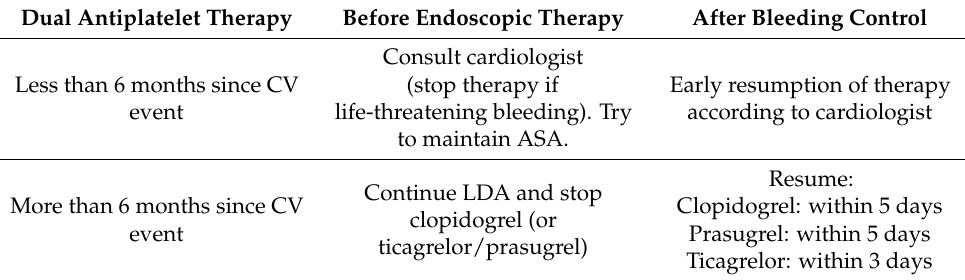
Table 3. Dual antiplatelet therapy management in non-variceal upper GIB. Dual Antiplatelet